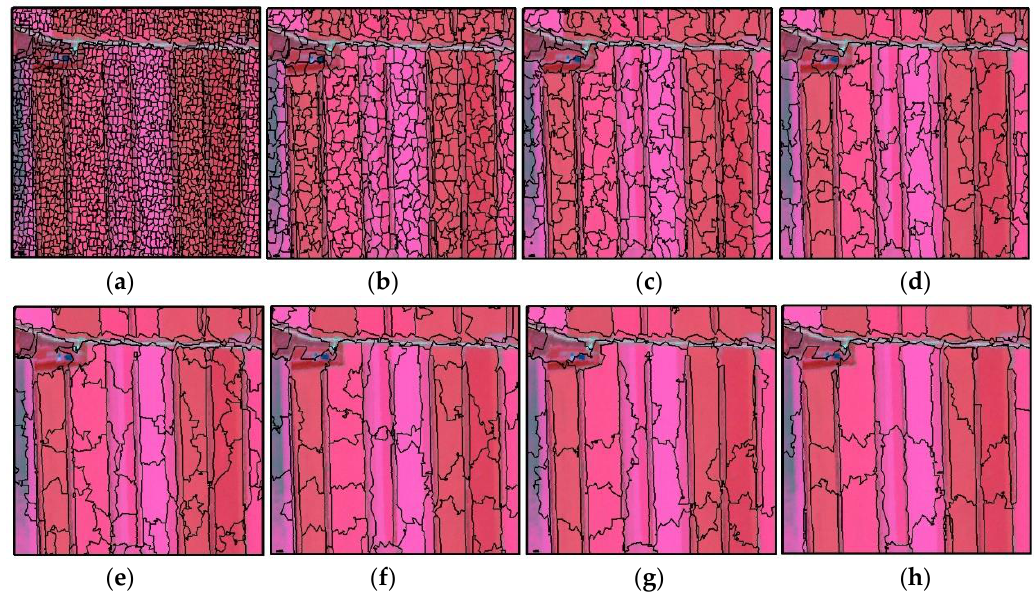
Figure 12. Segmentation effect of different segmentation sizes in Keshan farm (( a ) size5; ( b ) size10; ( c ) size15; ( d ) size20; ( e ) size25; ( f ) size30; ( g ) size35; ( h ) size40).